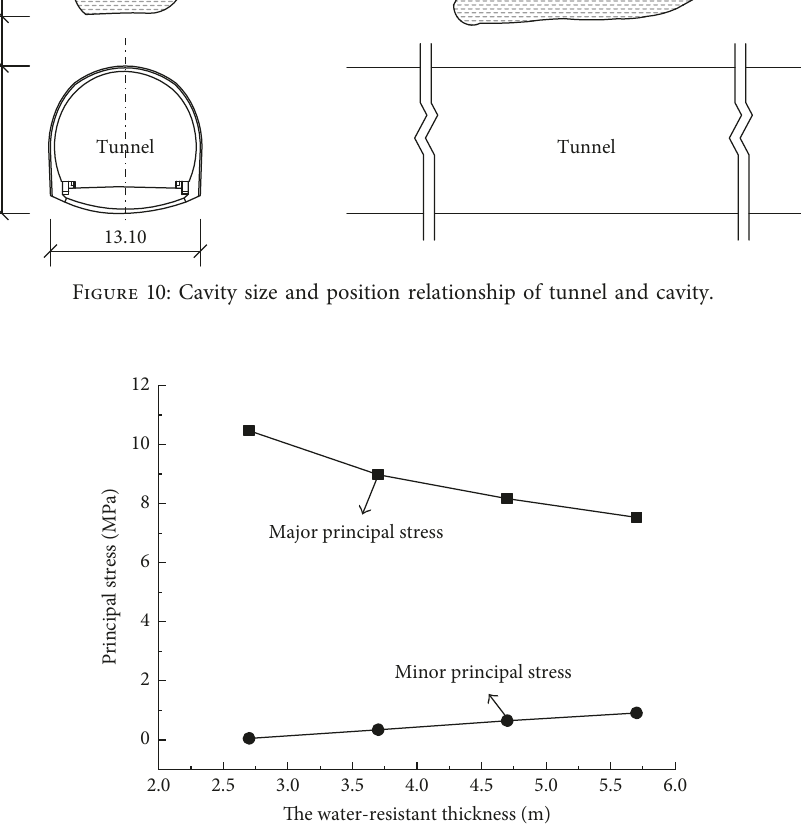
Figure 11: Relationship of the principal stress and the water-resistant thickness at the middle point of water-resistant